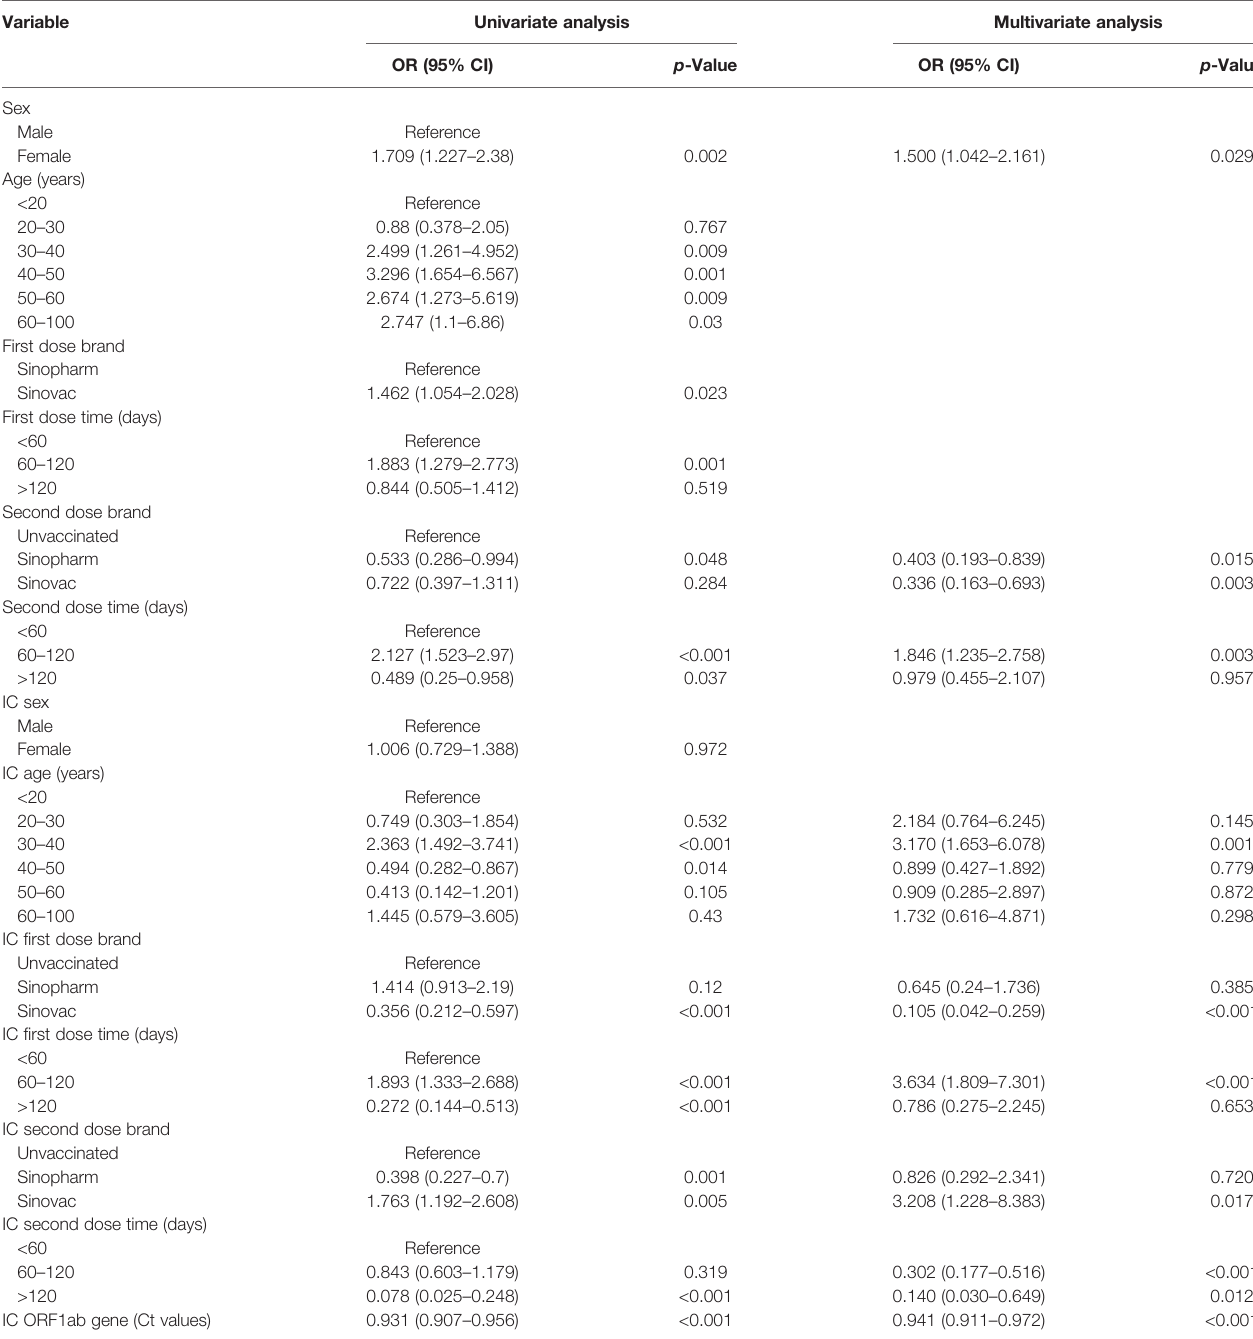
TABLE 2 | Univariate and multivariate logistic regression analyses of SARS-CoV-2 breakthrough infection in vaccinated